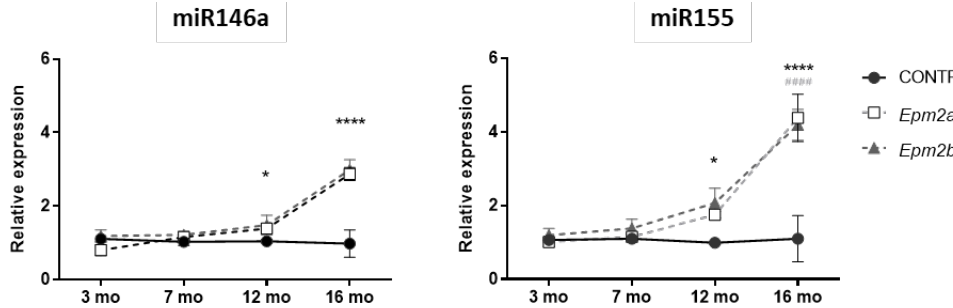
Figure 2. Expression of miR-146a and miR-155 increases with age. Total RNA was extracted from brain homogenates of 3 mo, 7 mo, 12 mo, and 16 mo WT and LD KO mice ( Epm2a − / − , Epm2b − / − ), and quantitative real-time PCR analyses were performed using the TaqMan™ probe system. The relative expression of both microRNAs was determined using the comparative 2 − ∆∆ CT method with the RNU6 gene as an internal reference. Statistical significance was calculated as #### p < 0.0001 for Epm2a − / − mice, and * p < 0.05, **** p < 0.0001 for Epm2b − / − mice, when, in both cases, compared to control mice via two-way ANOVA ( n = 8).